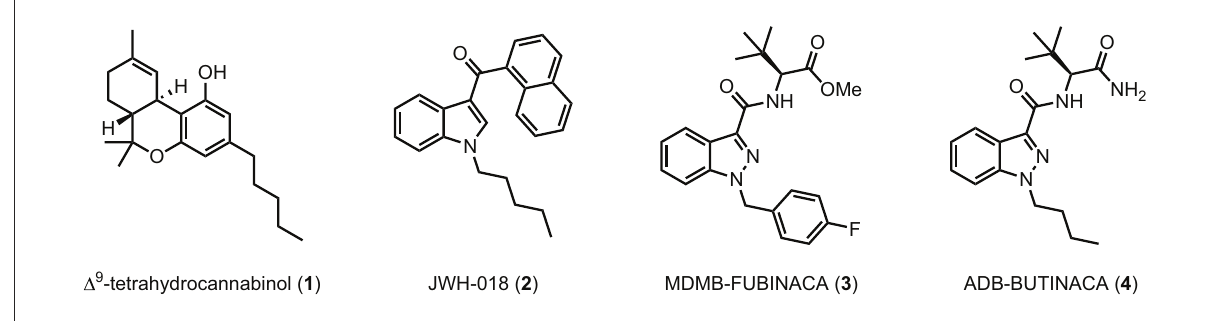
FIGURE1 1 9 -THC (1) , JWH-018 (2) , and selected SCRAs MDMB-FUBINACA (3) and ADB-BUTINACA (4) .